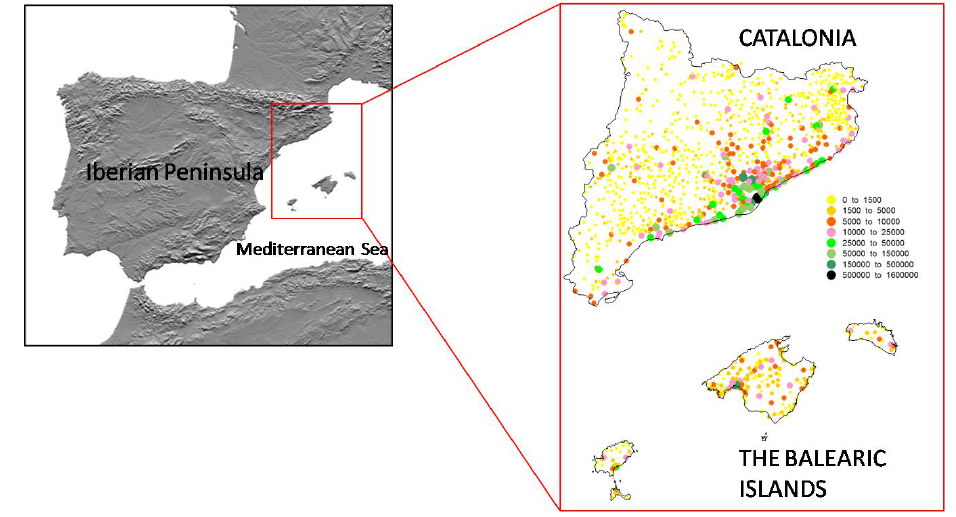
Fig. 1. Geographical situation of Catalonia and the Balearic Islands. On the right, density of population in both